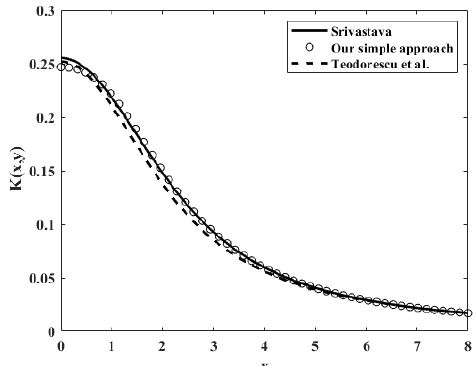
Quantum Rep. 2022 , 4, FOR PEER REVIEW Figure 2. Illustration of the Voigt function Figure 2. Illustration of the Voigt function K ( x , y ) in terms of x with y = 2.